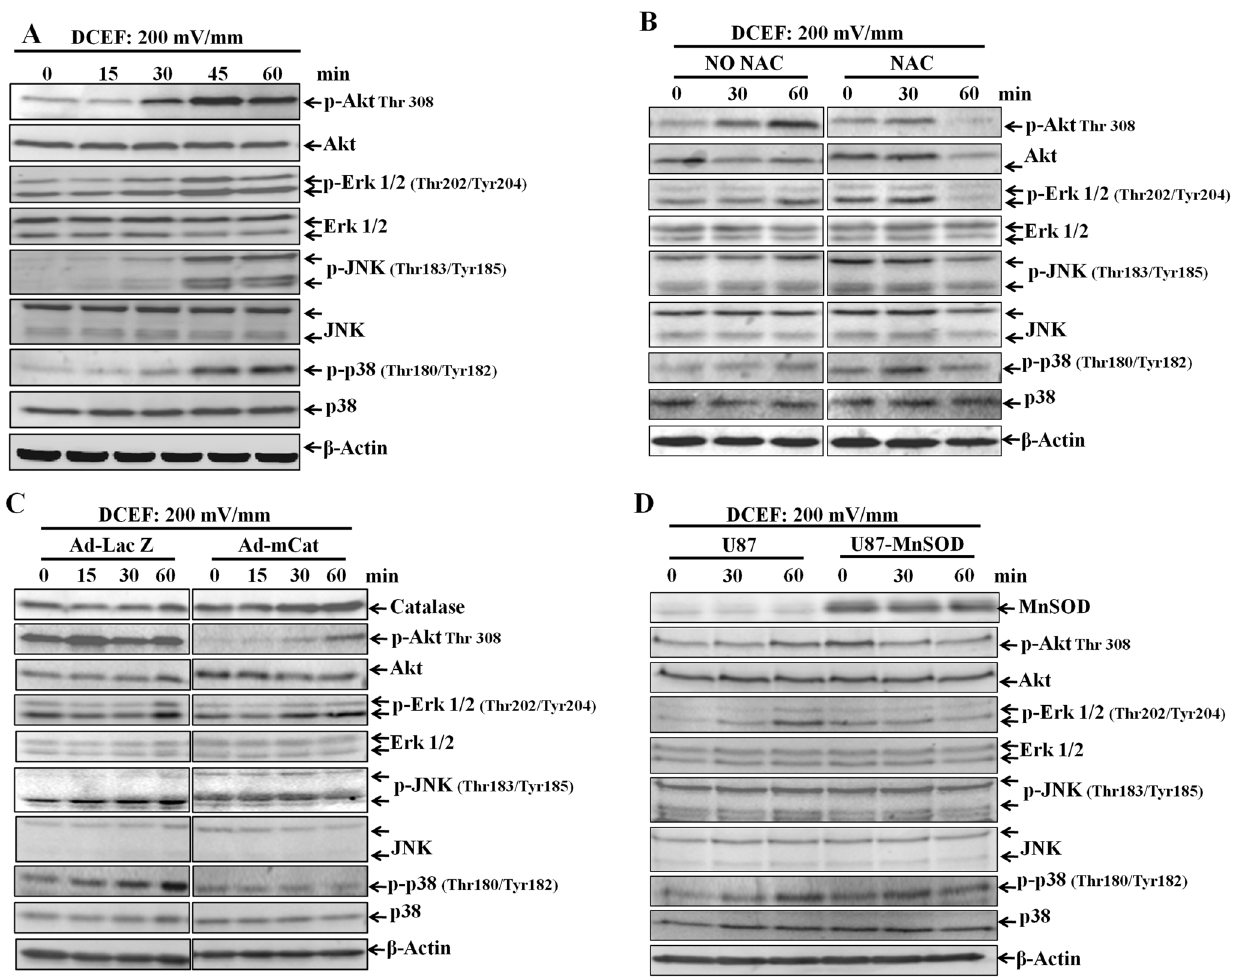
Figure 5. DCEF-stimulated activation of Erk1/2, JNK, and p38 in U87 glioma cells. U87 glioma cells were stimulated with 200 mV/mm DCEF for 0, 15, 30, 45, or 60 minutes (A). The cell lysate was probed with antibodies specific for p-Akt, total Akt, p-Erk1/2, total Erk1/2, p-JNK, total JNK, p- p38, and total p38. Activation of Erk1/2, JNK, and p38 in U87 glioma cells with or without 10 mM NAC pretreatment were stimulated with 200 mV/ mm DCEF for 0, 30, and 60 minutes (B). Activation of Erk1/2, JNK, and p38 in U87 glioma cells with or without overexpression of mCat were stimulated with 200 mV/mm DCEF for 0, 30, and 60 minutes (C). Activation of Erk1/2, JNK, and p38 in U87 glioma cells with or without overexpression of MnSOD were stimulated with 200 mV/mm DCEF for 0, 30, and 60 minutes (D). Data presented are a typical representation of a duplicated